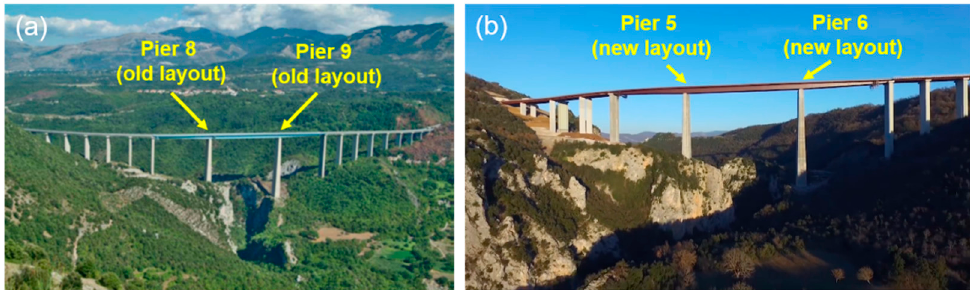
Figure 2. Comparison between: ( a ) the old (pre-2014) layout and ( b ) the new (post-2016) layout of the Viadotto Italia (modified from Wikipedia.org, Attribution-ShareAlike 4.0 International, CC BY-SA 4.0 license; https://creativecommons.org/licenses/by-sa/4.0/deed.en, accessed on 26 July 2022).